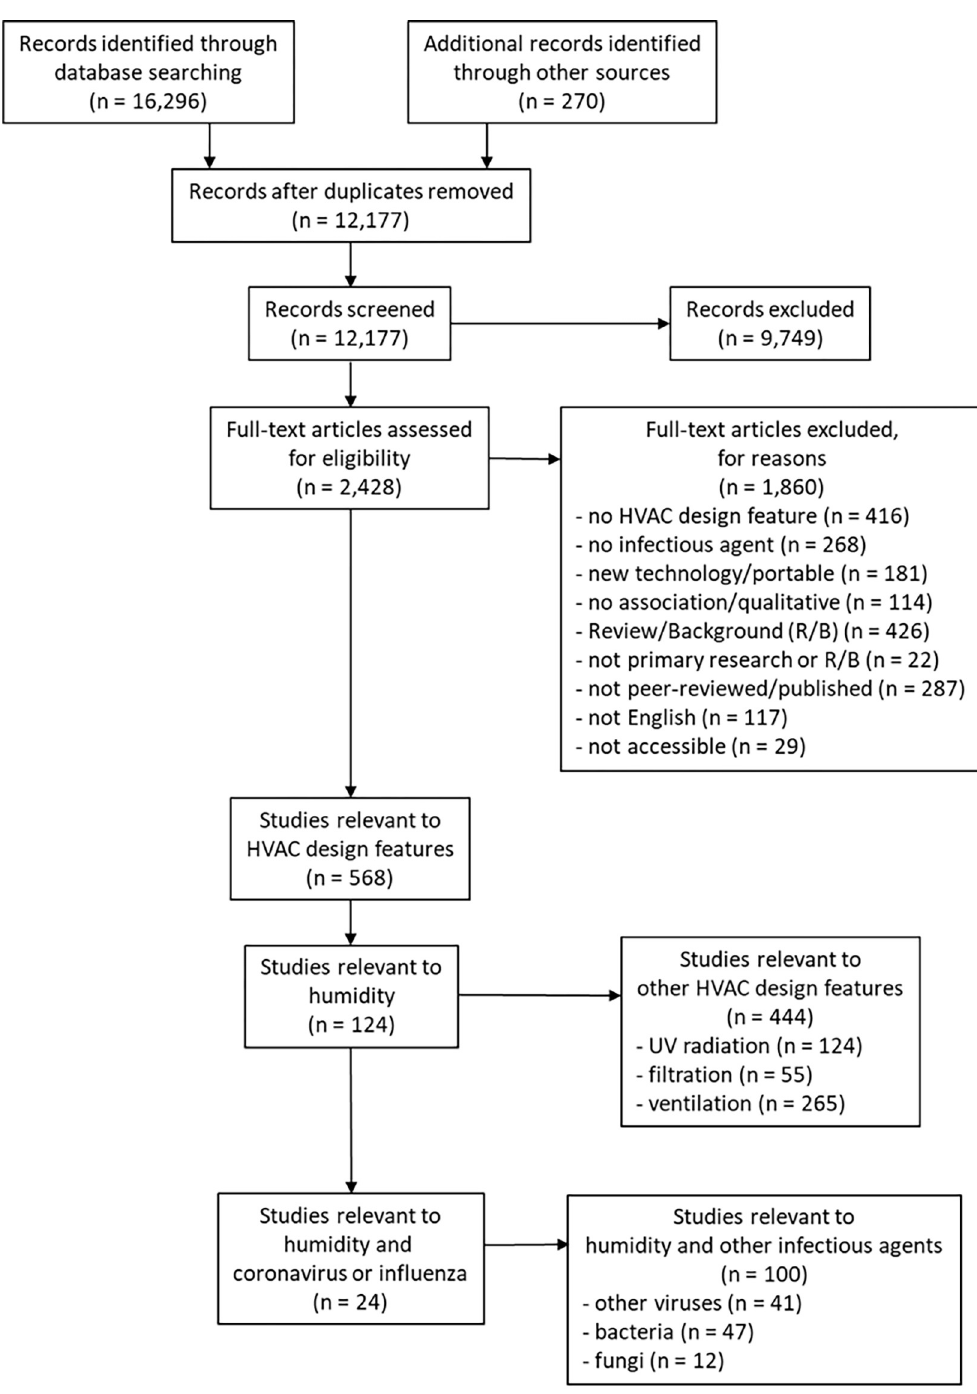
Fig 1. Flow of studies through the selection process. (note: search was conducted for all HVAC design features but only studies of relative humidity and coronavirus or influenza are included in this manuscript).